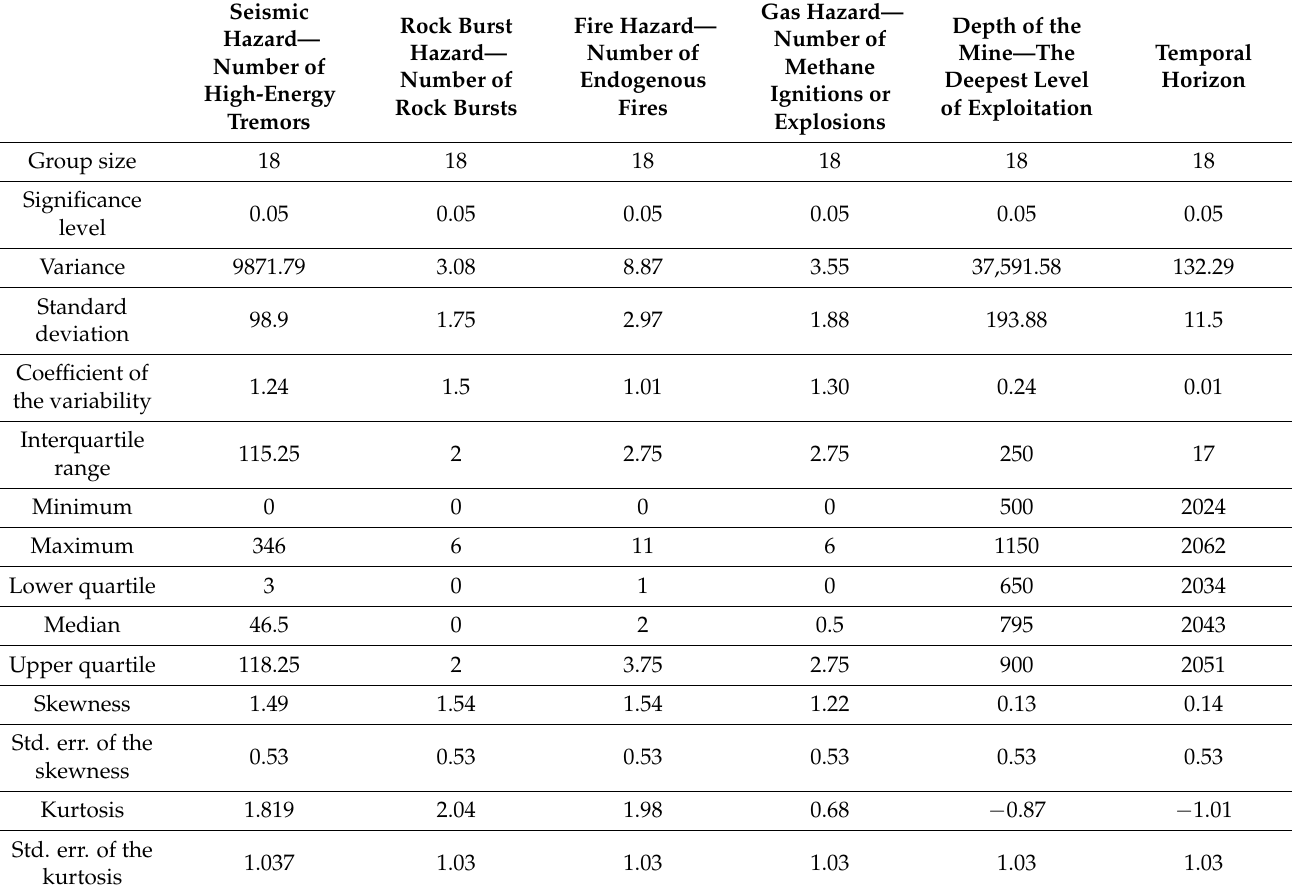
Table 1. The result of the statistical analysis of the criteria describing the temporal horizons of